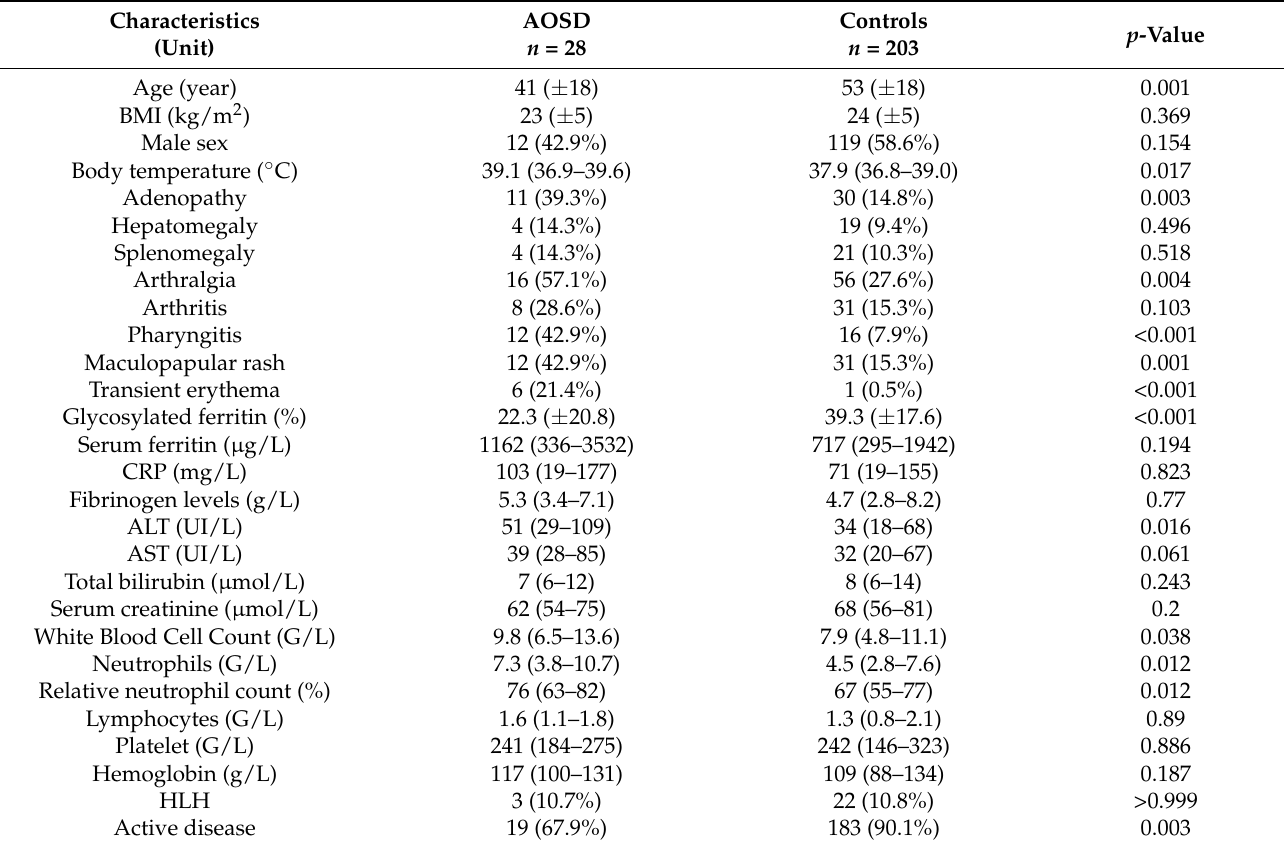
Table 1. Main clinical and biological characteristics of patients with adult-onset Still’s disease (AOSD) and controls.